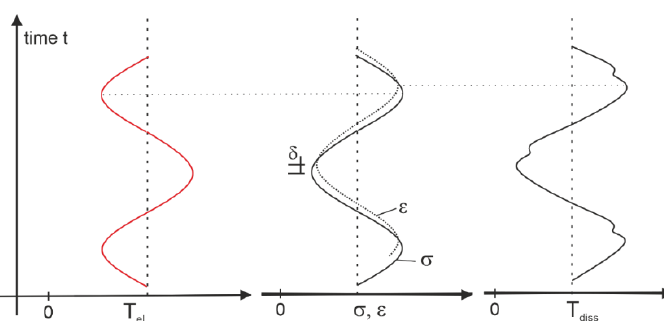
Figure 7. Externally applied mechanical stress ε causes the strain δ with inelastic delay δ , which leads to thermoelastic T el (left) and dissipational T diss (right) variations of temperature with a phase shift of approximately 180°.